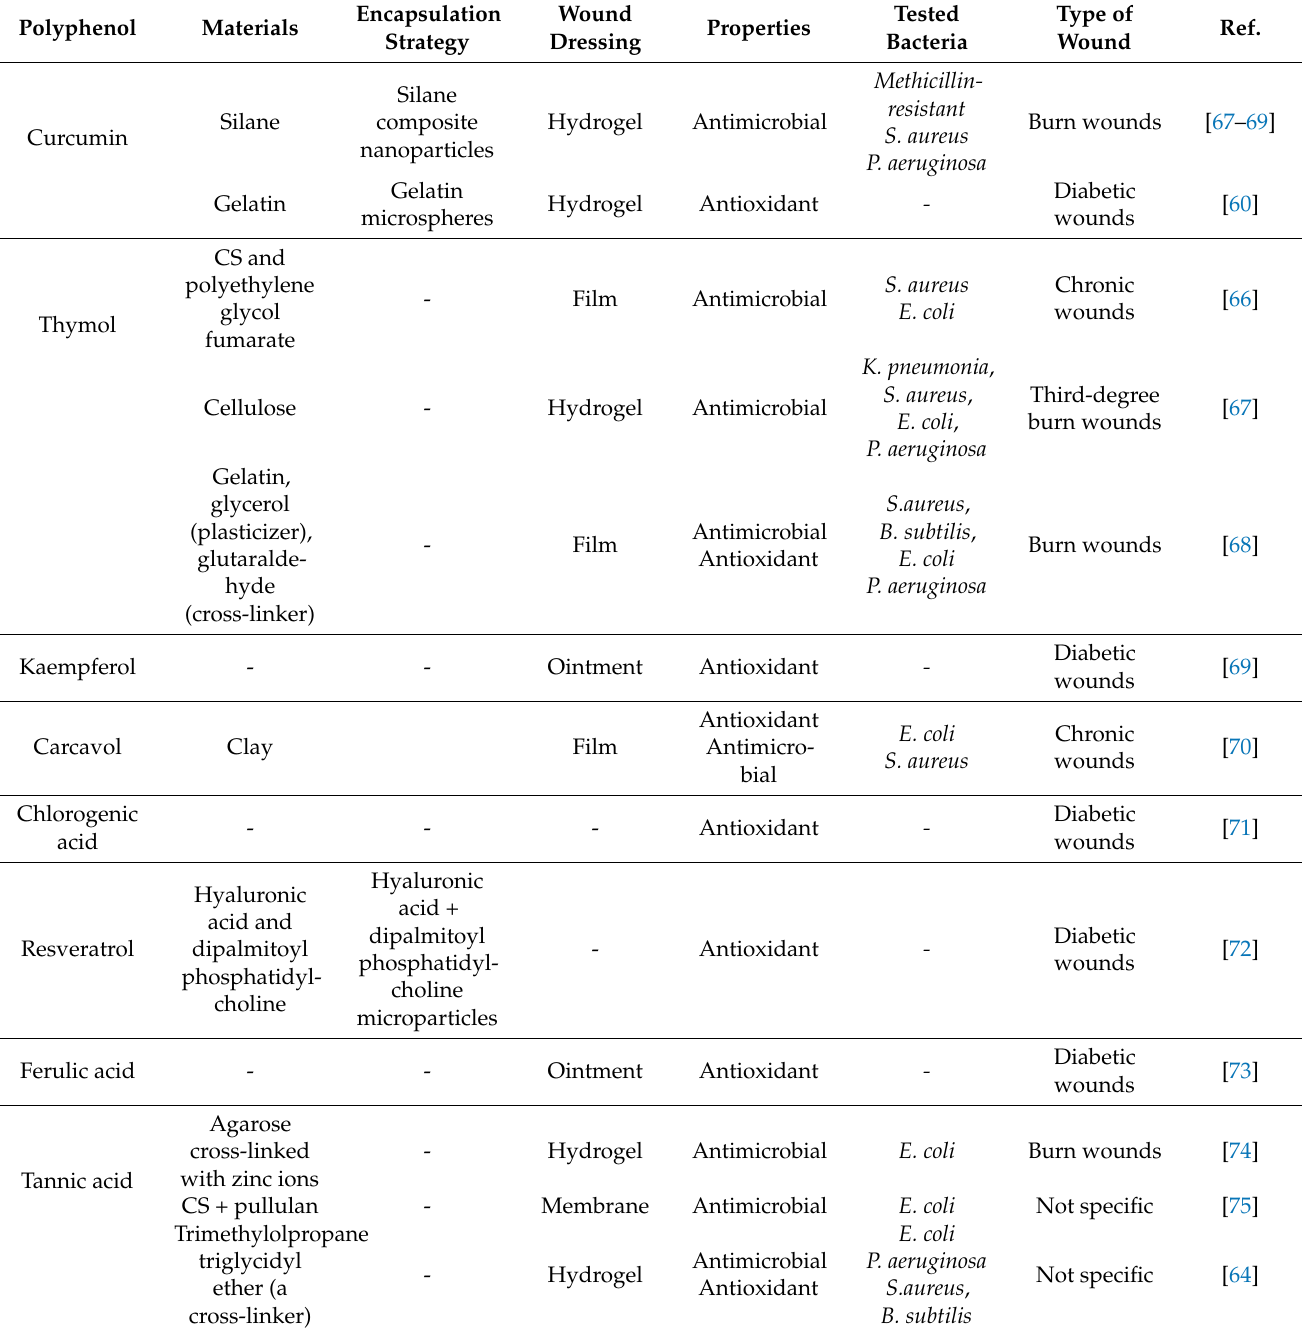
Table 1. Polyphenols with antioxidant or/and antimicrobial properties to promote wound healing [64,66–75].